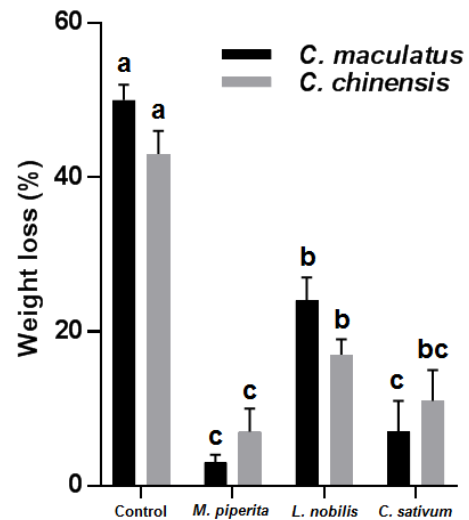
Figure 1. The persistence effect of M. piperita , L. nobilis , and C. sativum essential oils Nano granules on C. maculatus and C. chinensis (Mean ±SD) during cowpea storage.